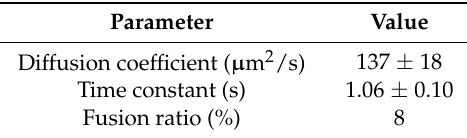
Figure 7. ( a ) Bright field image of the cell and the giant liposome before AC voltage application and the fluorescent image after DC voltage application at 0 s, 1 s, and 10 s. Electrofusion and Calcein transport occurred between a cell and a giant liposome. ( b ) Transition intracellular luminance normalized with background luminance. Table 1. The diffusion coefficient, the time constant and the fusion ratio were derived by the observation of the fluorescent inner solution of the liposome into the cell by electrofusion.